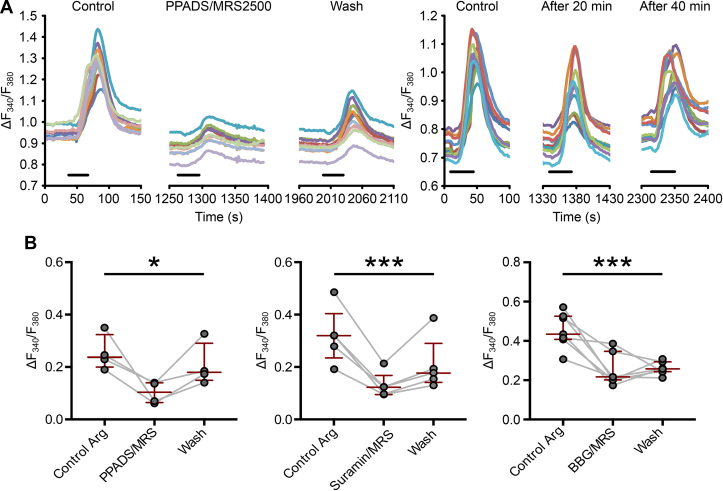
P2X and P2Y1receptors take part in the tanycyte amino acid detection pathway. (a) Comparison of ROI traces: the effect of a combination of PPADS and MRS2500 on tanycyte responses to l-arginine vs. time-matched control. (b) P2X and P2Y receptor antagonist combinations reduced tanycyte responses to l-arginine. PPADS/MRS2500 block P2Y1 and most P2X receptors except P2X4 and P2X6 (P = 0.0417, Friedman test, n = 4 slices (from 2 animals)). Suramin/MRS2500 block the same receptors as PPADS/MRS2500 with more specificity for P2X2 (P = 0.0008, Friedman test, n = 5 slices from 2 animals). BBG/MRS2500 block P2Y1, P2X2 and P2X7 (P = 0.0027, Friedman test, n = 7 slices (from 4 animals)).